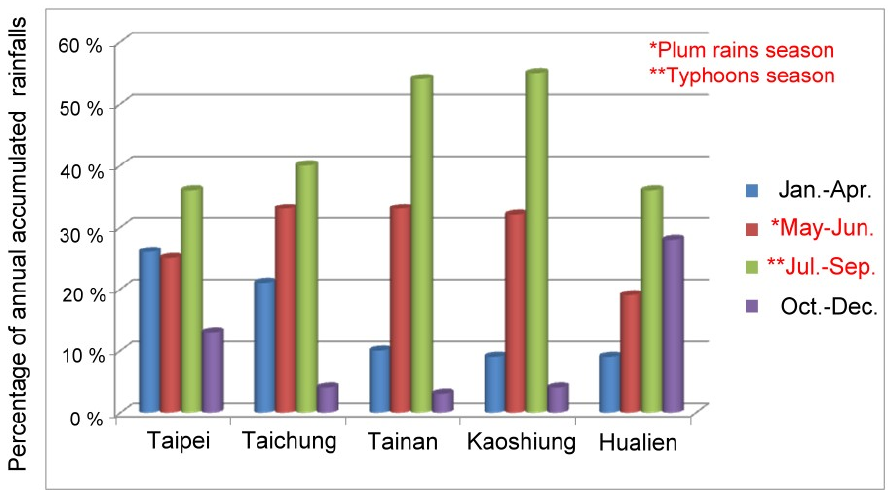
Figure 3. Annual distribution of accumulated rainfall (Courtesy of CWB,